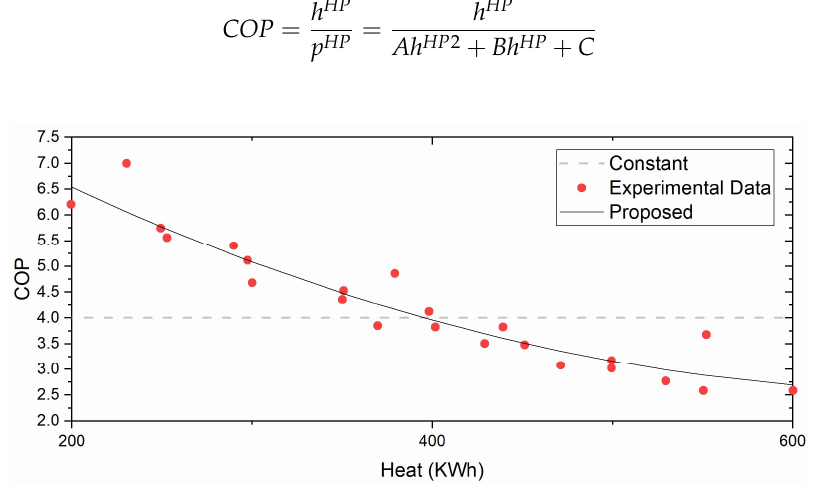
Figure 4. COP in the proposed heat pump model.